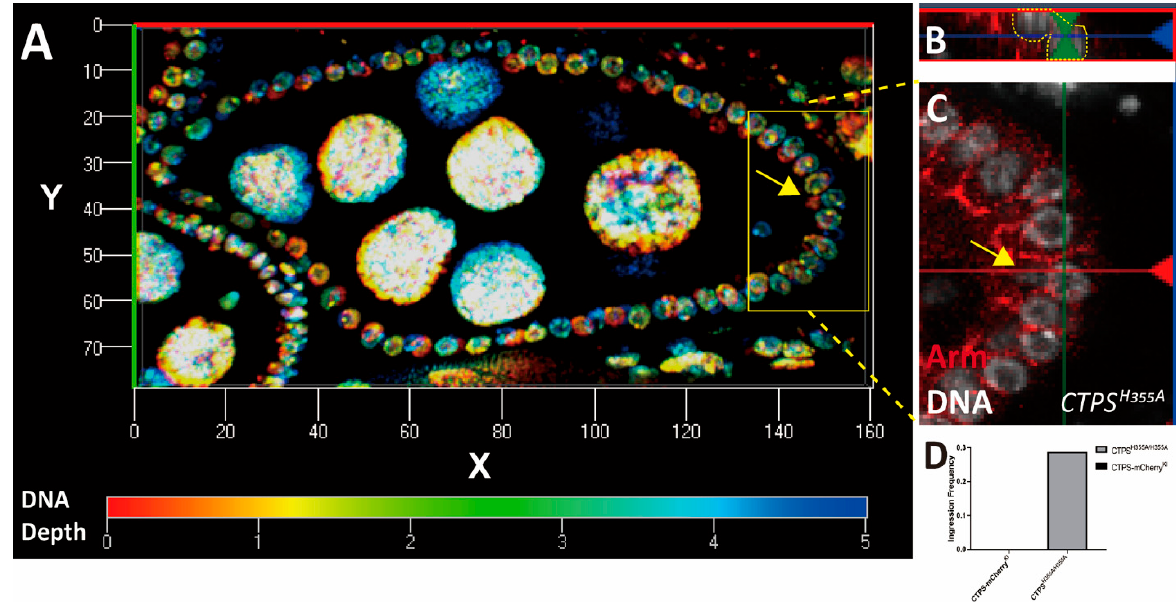
Figure 4. Three dimensional view of follicle cell ingression. ( A ) Cross section of a three-dimensional CTPS H355A egg chamber. A three-dimensional view of DNA stacked in layers. The interval between each layer is 0.5 μ m, and a total of 12 layers are superimposed. The color from red to blue indicates the depth of DNA. ( B ) Side view of an ingressive nucleus. ( C ) On the xz plane, with the yellow dotted line marking the ingressive cell. ( D ) Quantification of the ingression frequency, 20 stage 8 egg chambers were counted per genotype.